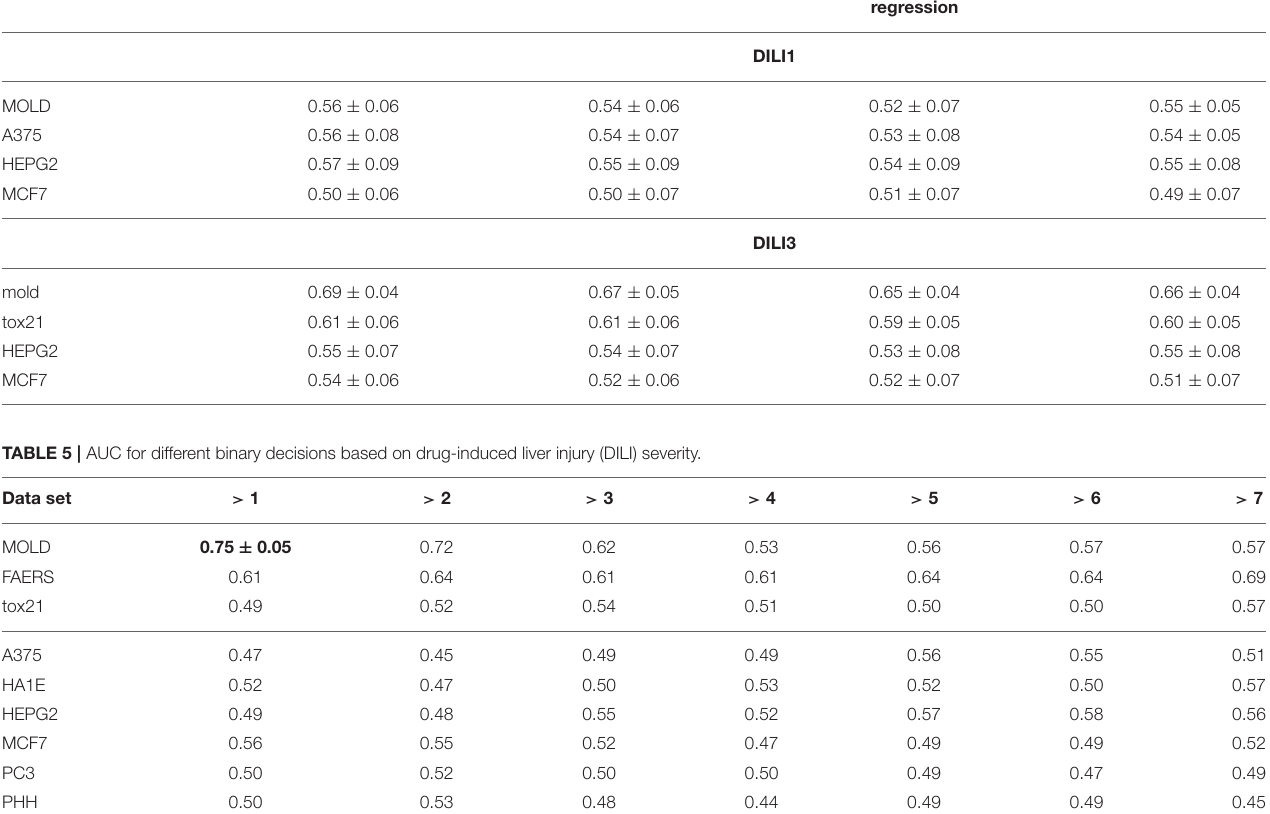
TABLE 4 | Different classifiers comparison (AUC) on chosen data sets for DILI1 and DILI3. Data set